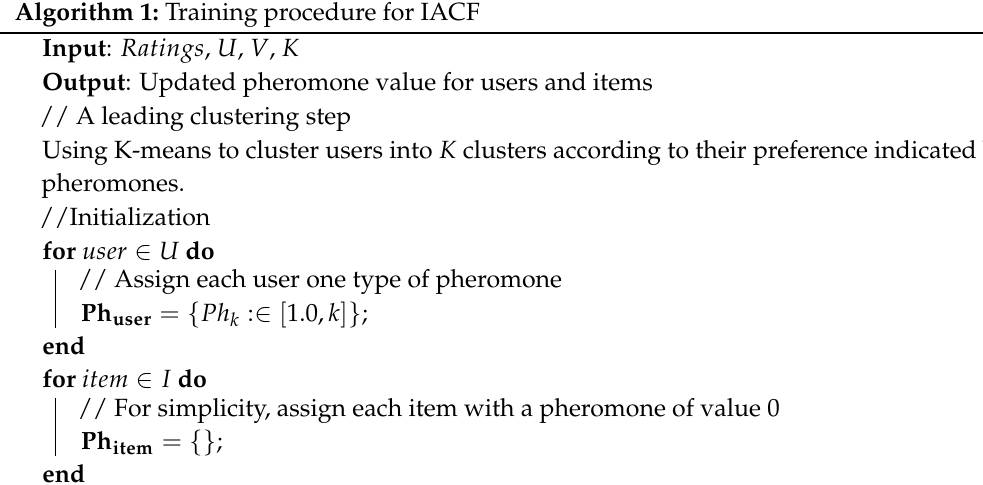
Algorithm 1: Training procedure for